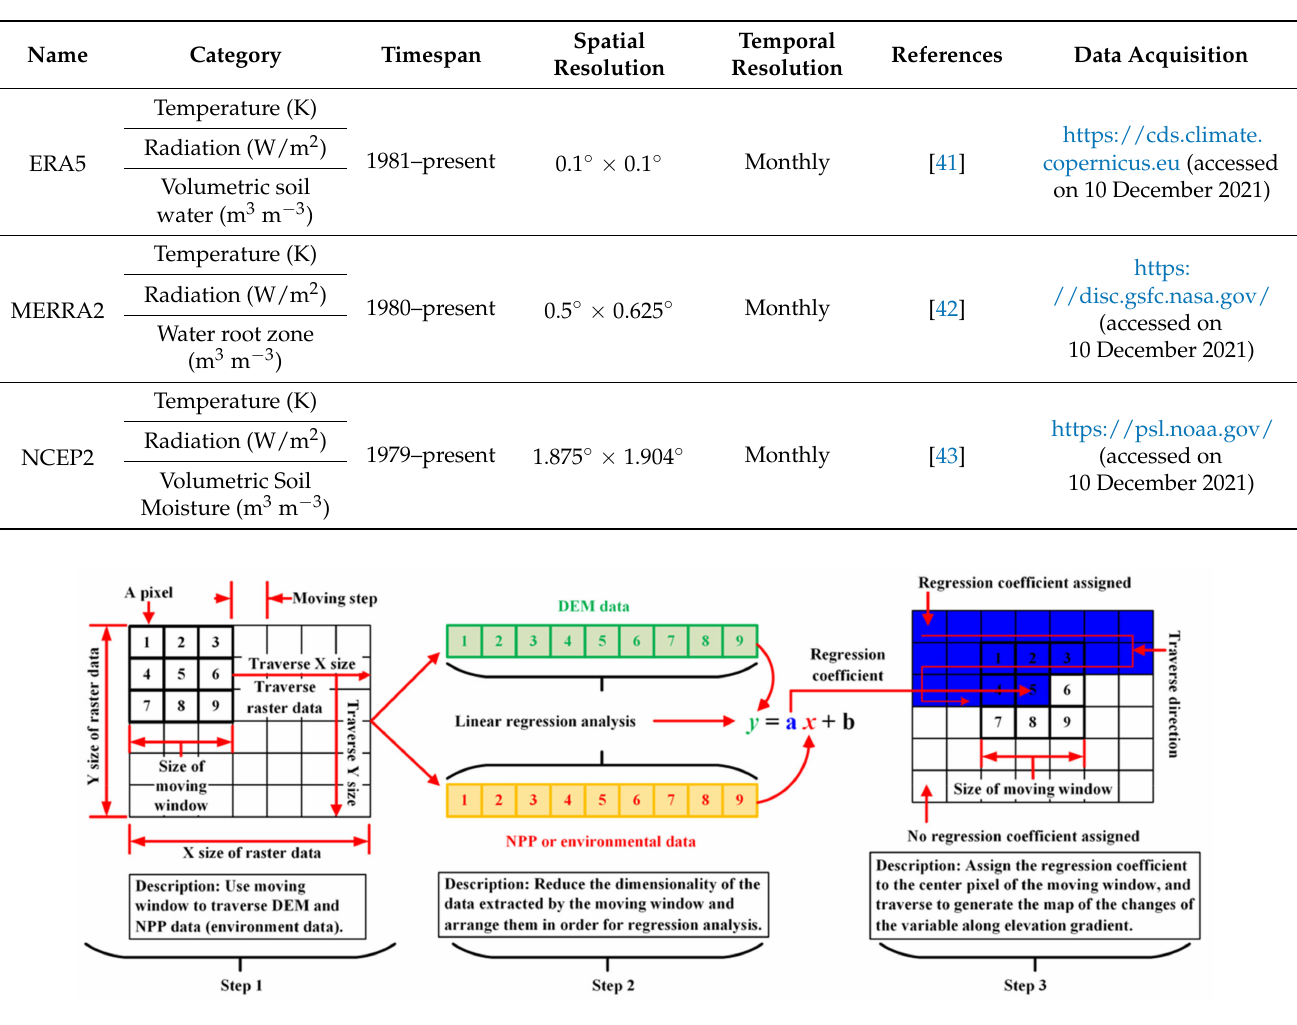
Figure 1. Schematic diagram of the calculation of the NPP or environmental factors changes along EG. We take a 3 × 3 window as an